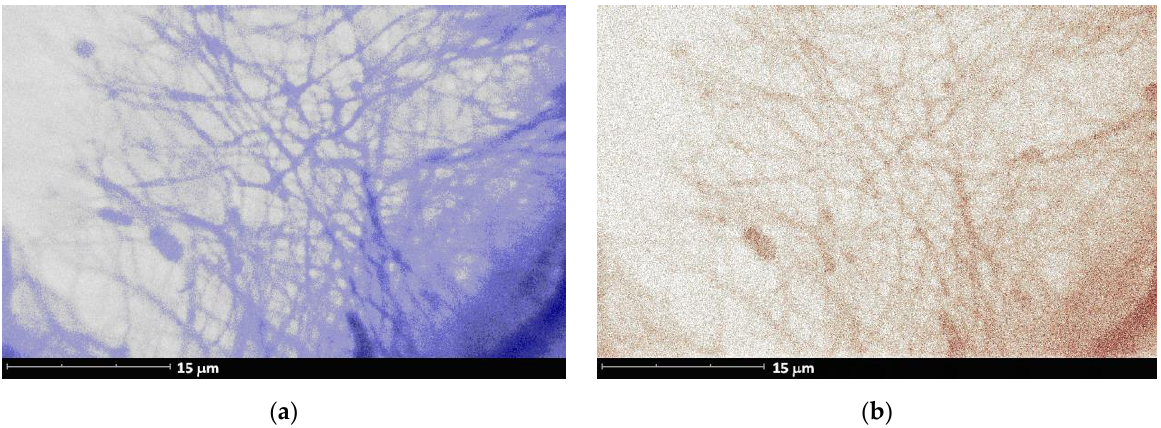
Figure 9. The distribution of ( a ) Ca and ( b ) N in ES fibrous film V3 (SEM EDX mapping data).